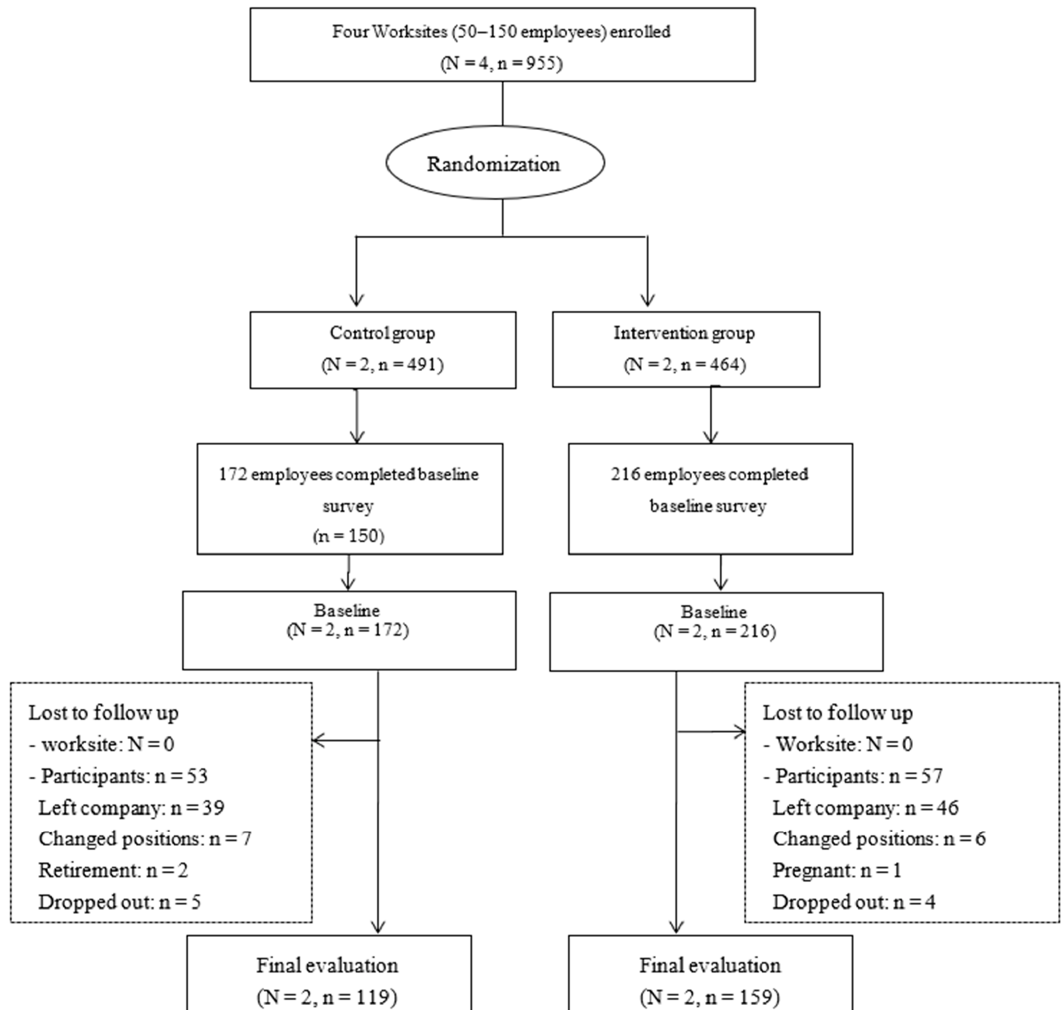
Figure 1. Flow of site and participant recruitment, screening, and assessment. Baseline socio-demographic characteristics were comparable for intervention and control worksites except for the age and the educational level (Table 1). Table 1. Characteristics of the study participants at the baseline.